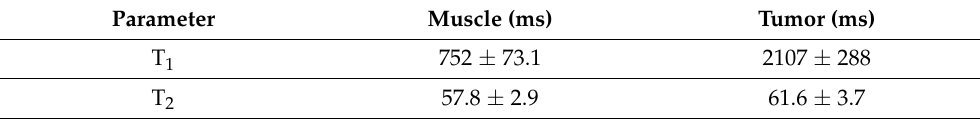
Table 1. Relaxation times for mouse